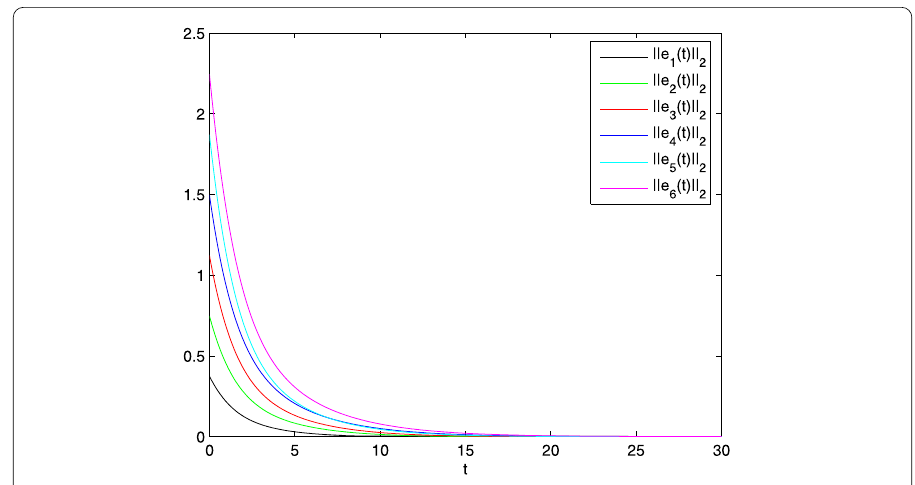
Figure 5 The synchronized error (cid:2) e i ( t ) (cid:2) 2 , i = 1,2,3,4,5,6, of system (33) under pinning control (18).